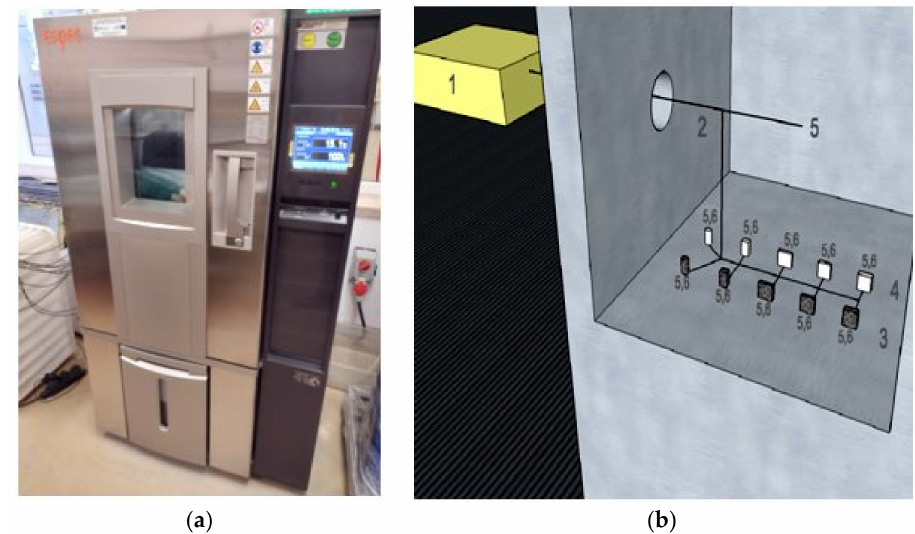
Figure 6. ( a ) A photograph of the Espec climatic chamber during the research; ( b ) Scheme of the test stand, where: 1, recorder; 2, interior of the climate chamber; 3, research samples of the PCM composite with recyclate; 4, pure PCM test samples; 5, temperature sensors; 6, heat flux density sensors.